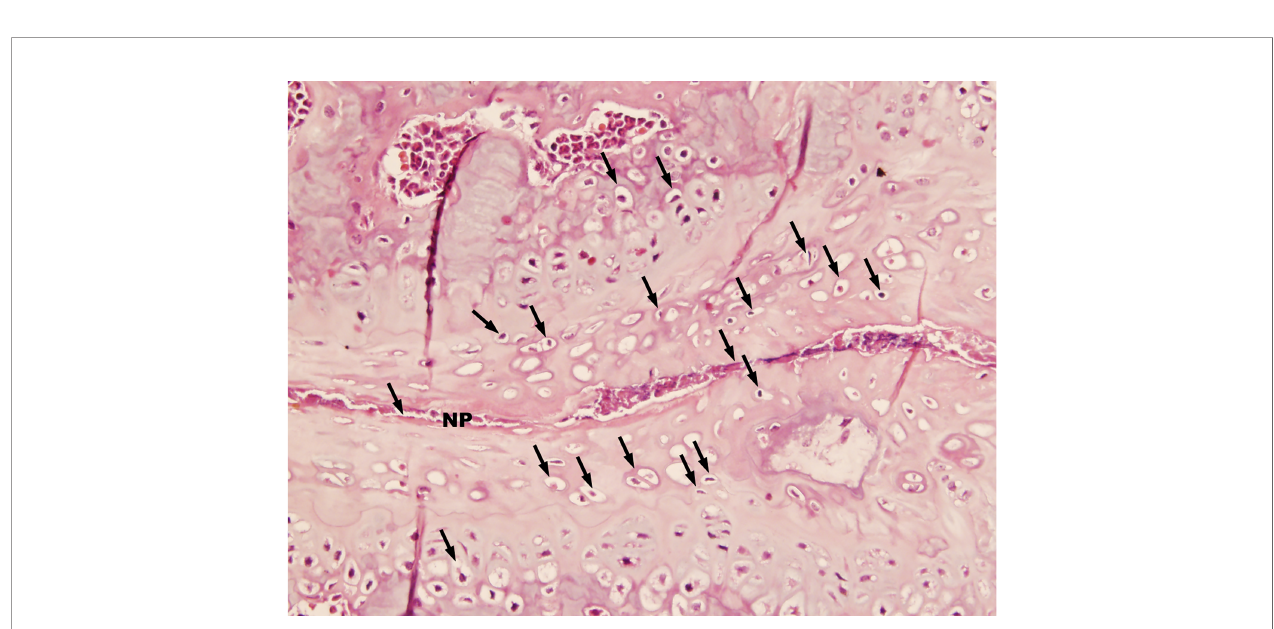
FIGURE 2 | Advanced pathological changes of an intervertebral space in a PGISp mouse (HE, × 400). A large number of chondrocytes (black arrows) appeared next to the very much narrowed intervertebral space. Part of the intervertebral space seemed to have